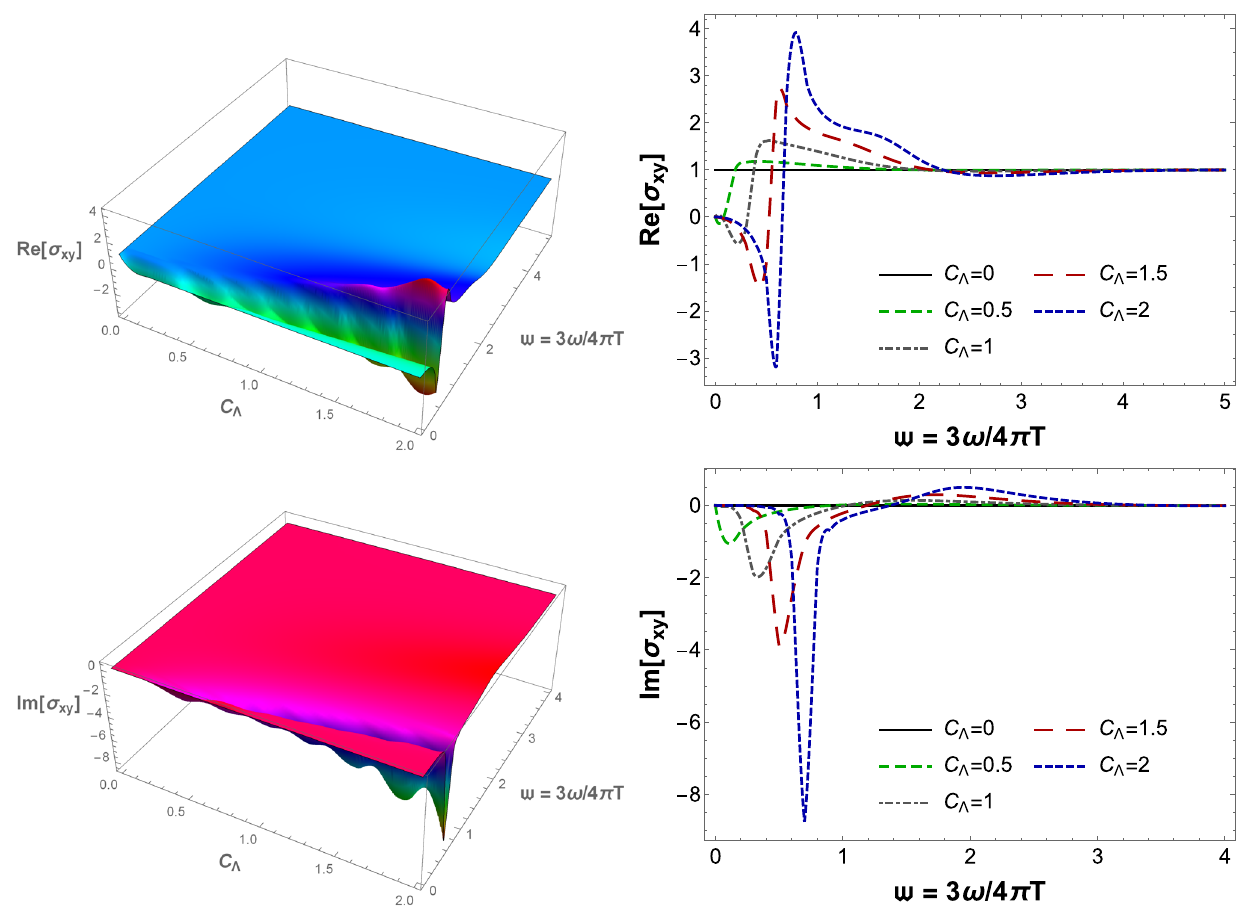
Fig. 12 Real and imaginary parts of the Hall AC conductivity as functions of ( C (cid:12) = (cid:12) L / 2 , w = 3 ω/ 4 π T ) at fixed θ = 1. These results were generated with the mass function M ( u ) = tanh ( u 2